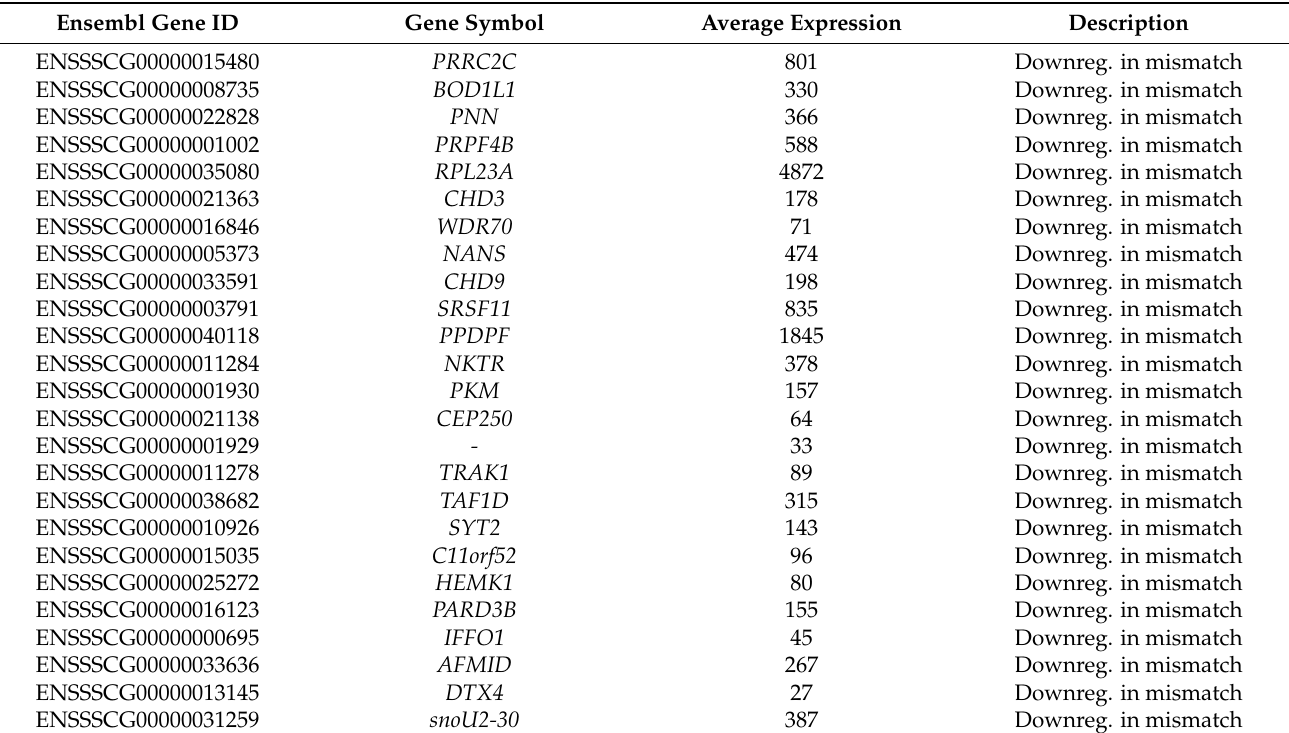
Table 1. Differential expressed genes at 4.5 weeks of age between the match (LL and HH) and mismatch groups (HL and LH) describing the interaction effect between piglets during the nursery phase and maternal diet during late gestation. Average expression is the mean of normalized counts of all samples. Ensembl Gene ID Gene Symbol Average Expression Description 801 Downreg. in